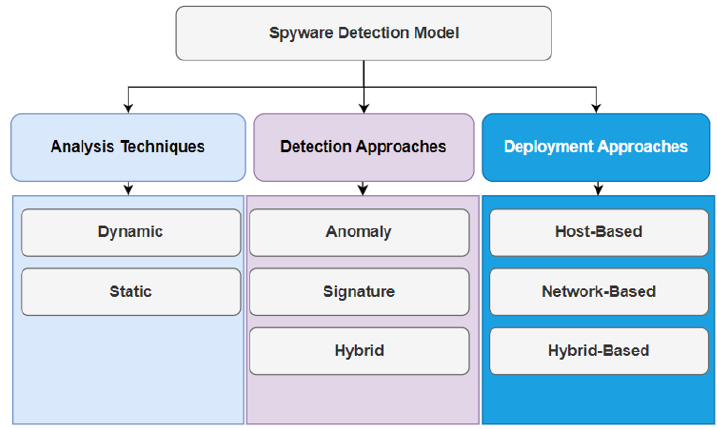
Figure 2. Spyware detection approaches.